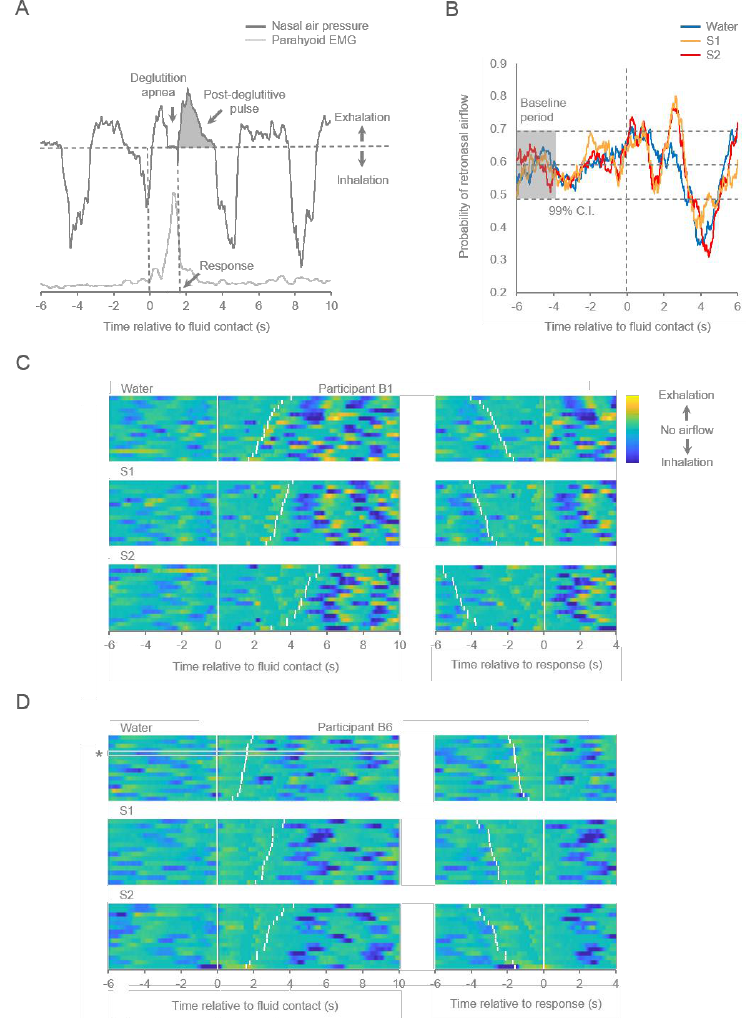
Figure 2. Nasal airflow during performance of the oral fluid discrimination task. ( A ) Illustrative nasal air pressure and parahyoid EMG traces recorded during a single trial with water as the sampled fluid. The horizontal dashed line represents the absence of airflow (session-wide mode). The vertical axis reflects voltage in arbitrary units of magnitude. Shaded region shows post-deglutitive airflow. ( B ) Probability of retronasal airflow for water, S1, and S2 trials. Middle horizontal dashed line represents the mean of a baseline period (−6 to −4 s) sampling distribution derived from 84,000 samples occurring across all correct water trials; upper and lower dashed lines represent 99% confidence intervals of this sampling distribution. See Section 2 for details. ( C , D ). Representative contour plots of nasal air pressure for two participants (B1, B6) across all correct water, S1, and S2 trials. Vertical axis reflects trials, which are sorted according to response latency. The horizontal axis reflects time (s) relative to fluid contact (left panels) or response initiation (right panels) in each trial. White event markers reflect the time of occurrence of fluid contact (left marker) and the behavioral response (right marker) in each trial. The magnitude of retronasal (exhalation) or orthonasal (inhalation) airflow is reflected by color intensity normalized for each participant, with the minimum voltage value pinned to the lowest color bar value (dark blue) and the session-wide mode voltage (no airflow) pinned to the middle color bar value (teal). * Identifies the trace illustrated in Panel ( A